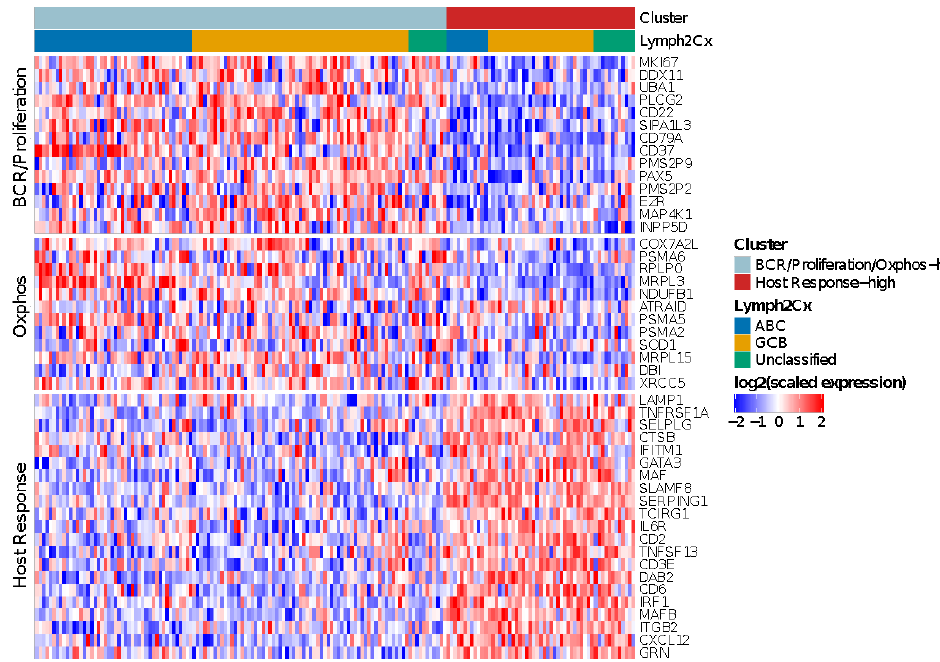
Figure 3. Heatmap showing the relative expression levels of BCR/Proliferation, Host Response (HR) and Oxphos genes used to reproduce the Monti consensus clustering. The HR cluster was validated in 55/175 HOVON-84 cases; the remaining cases showed low expression of HR genes, but no distinct clustering based on BCR/Proliferation and Oxphos genes.